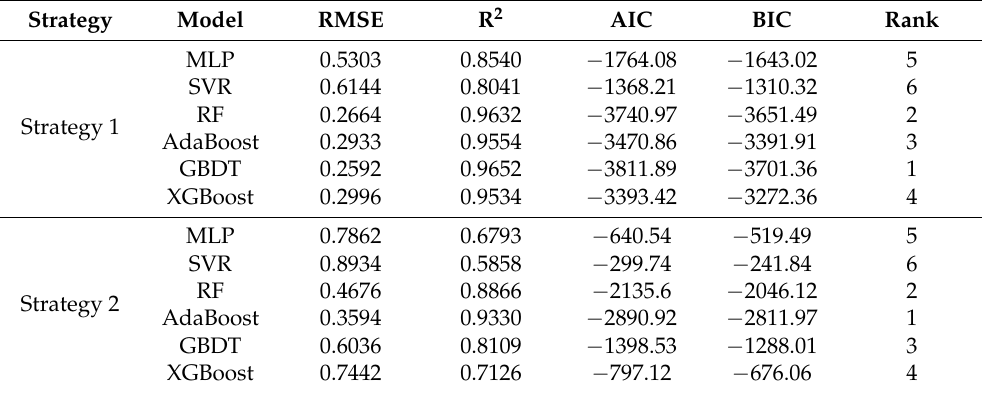
Table 7. Fitting statistics for 6 artificial intelligence procedures (MLP, SVR, RF, AdaBoost, GBDT and XGBoost).